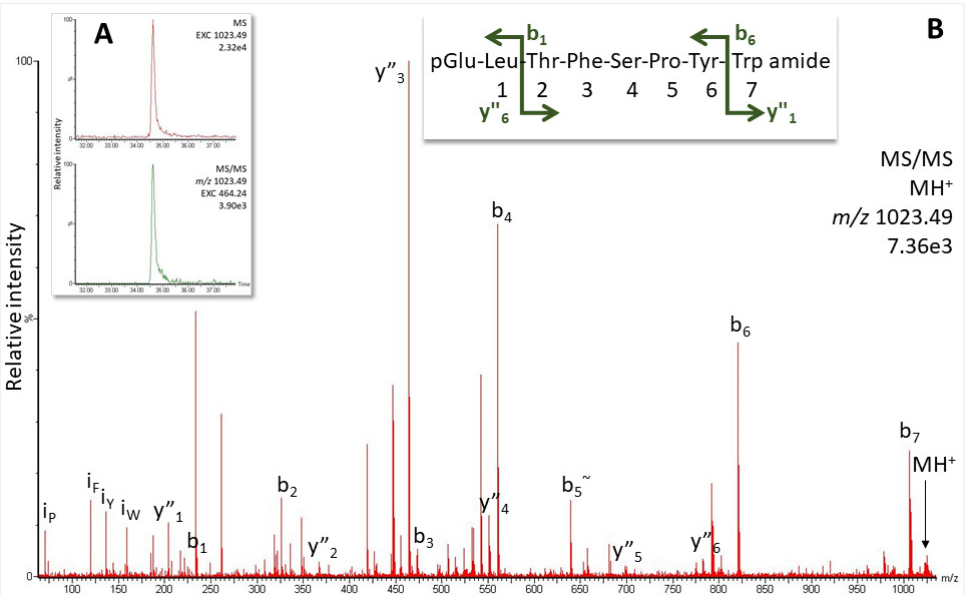
Figure 3. MS target analysis for Volpe-CC in P. tapulus (1 µL injection, equivalent to the glandular content of 0.85 CC). ( A ) Extracted ion chromatograms (EXC), from the top: for the singly-charged peptide ion ( m/z 1023.49) in the overview scan and for the MS/MS of the singly-charged peptide ion on the dominant y 3 ion. ( B ) MS/MS spectrum of the singly-charged peptide ion. Peaks were labeled according to the b- and y-ion series as calculated in Supplementary Figure S3. For original spectrum also see Figure S3; for validation, see Figure S4.